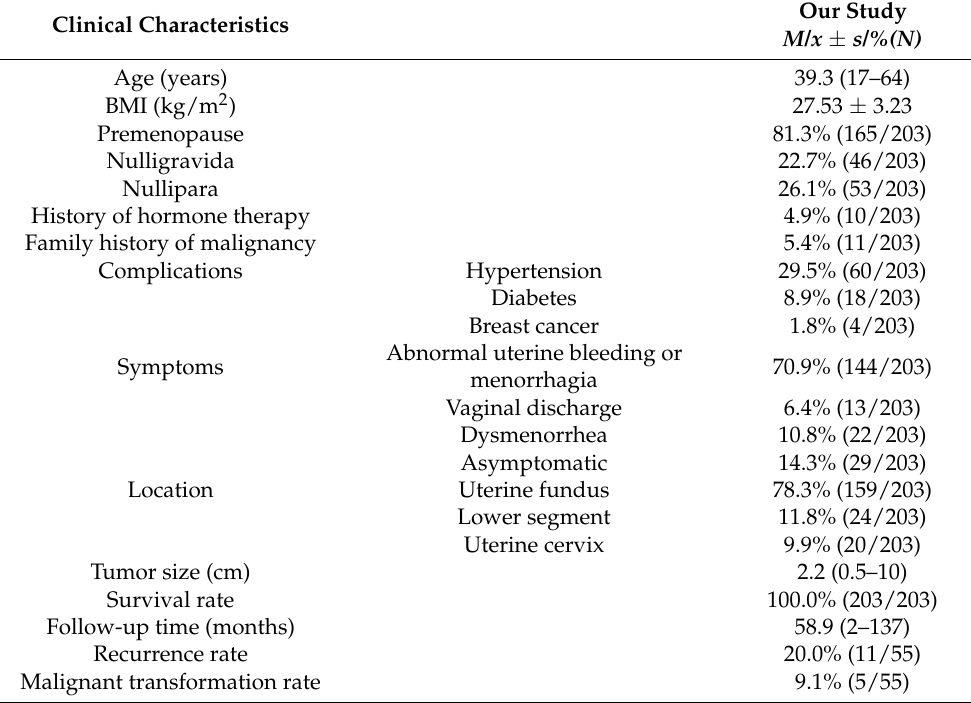
Table 1. Clinical characteristics of APA in our